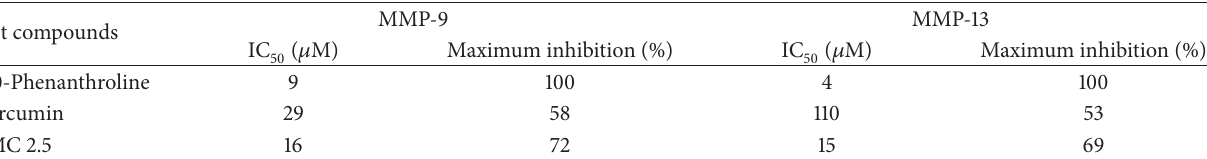
Table 1: Potency of CMC 2.5 as an MMP inhibitor.